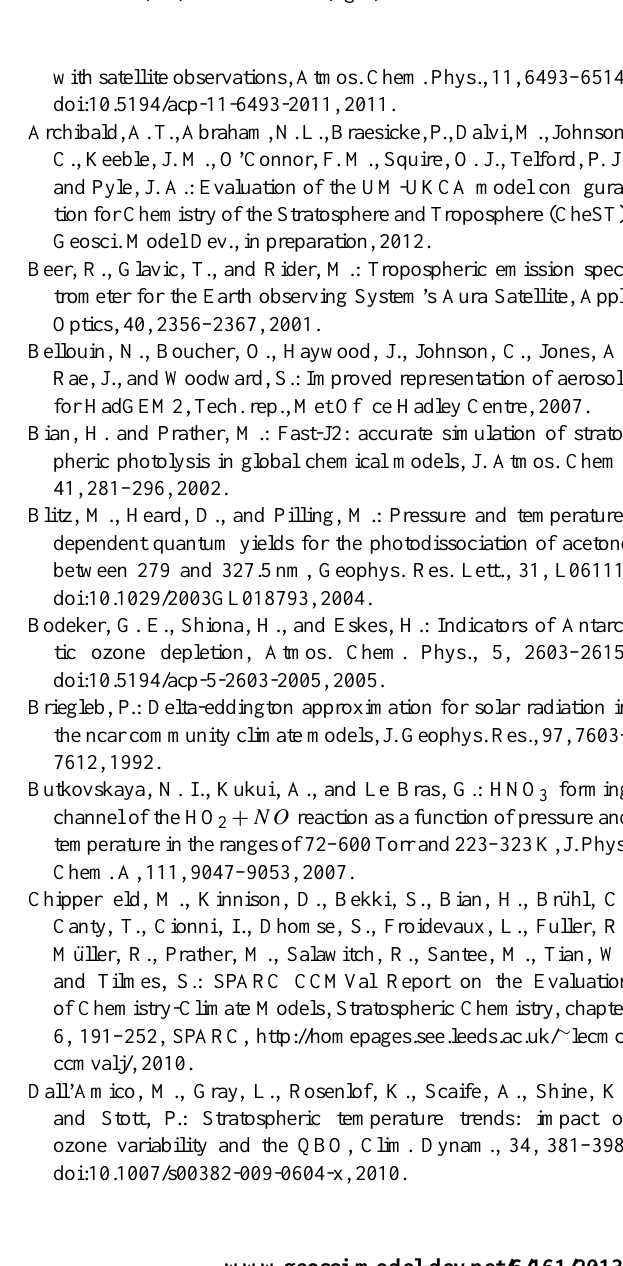
Fig. 9. Comparison of monthly mean O 3 profiles between the stratospheric version of the chemistry model and sondes from the SHADOZ network over an example site, in this case Fiji (18 ◦ S, 178 ◦ E). The left-hand plot shows annual mean profiles in the model and in the observations. The right-hand plots resolve the variation over the year in observations (left) and the model